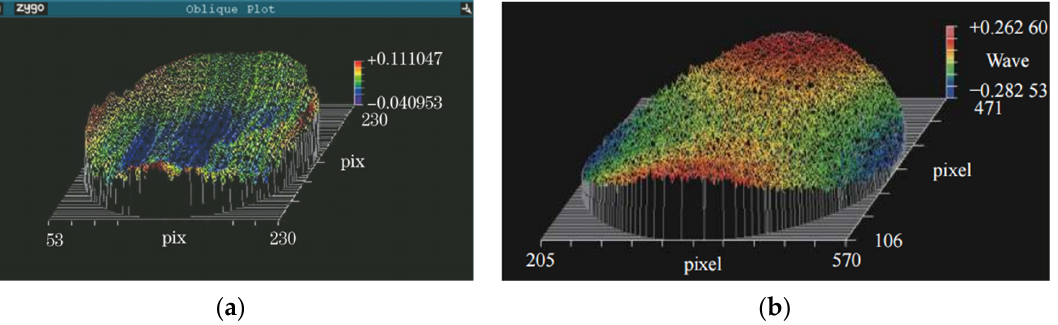
Figure 11. Convex grating zeroth-order optical wavefront morphology. ( a ) Wavefront morphology [65]; ( b ) Wavefront morphology [84].